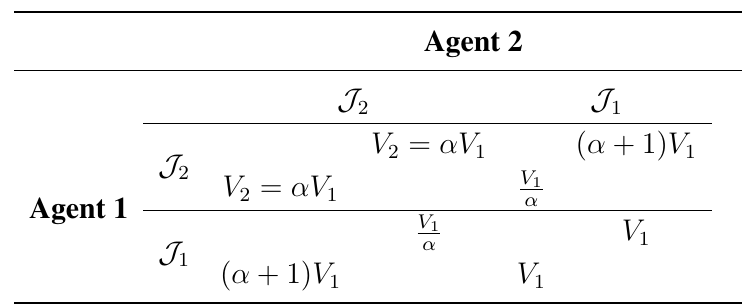
Table 1. The basic dilemma